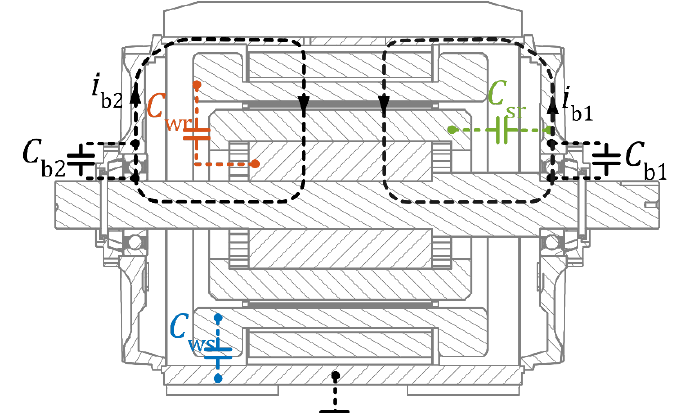
Figure 5. Internal capacitances in the electric machine.